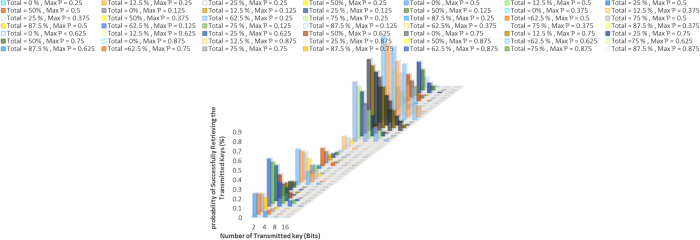
Combined Fig. 2C–F “drawn by A.F”.